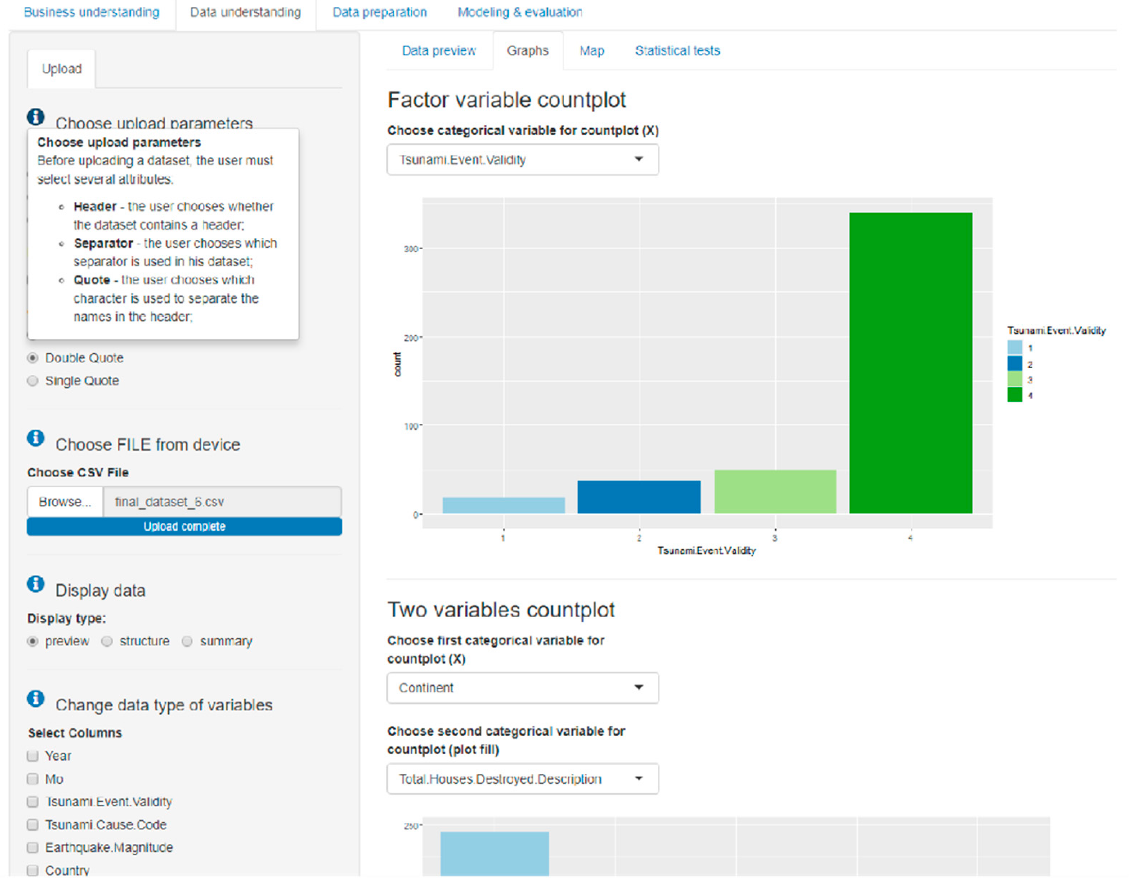
Figure 9. The main screen of the data exploration component.